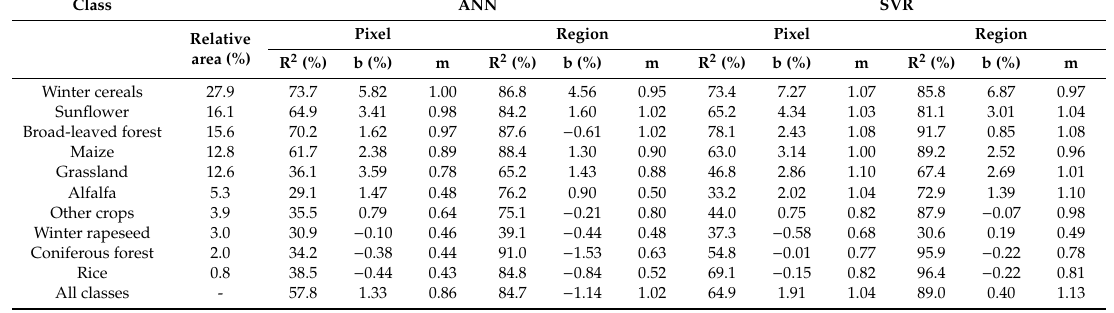
Table 5. Results from the validation of the estimated AFIs: per pixel and after aggregation to the 80 artificial regions of 10x10 km 2 . R 2 , b, and m are the coe ffi cient of determination, intercept and slope of the linear regression of true area fractions (%) on estimated area fractions (%). The column Relative area indicates the relative importance of each class for the total of both test sites according to the reference Sentinel-2 maps. ANN-artificial neural network; SVR-support vector regression. The last row shows the result of the regression performed with data from all pixels, regardless of their class.